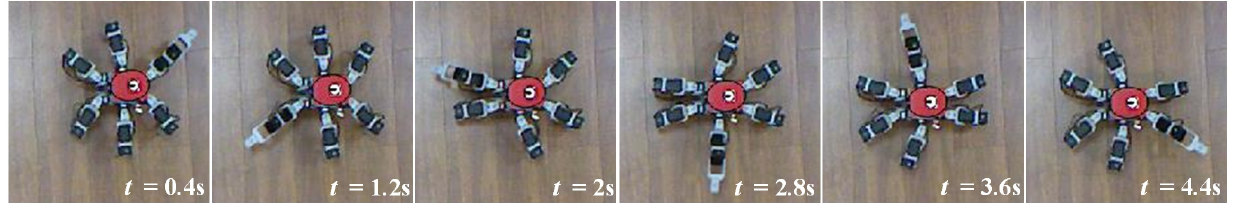
Figure 13. The experimental platform for testing the performance of the hexapod robot.